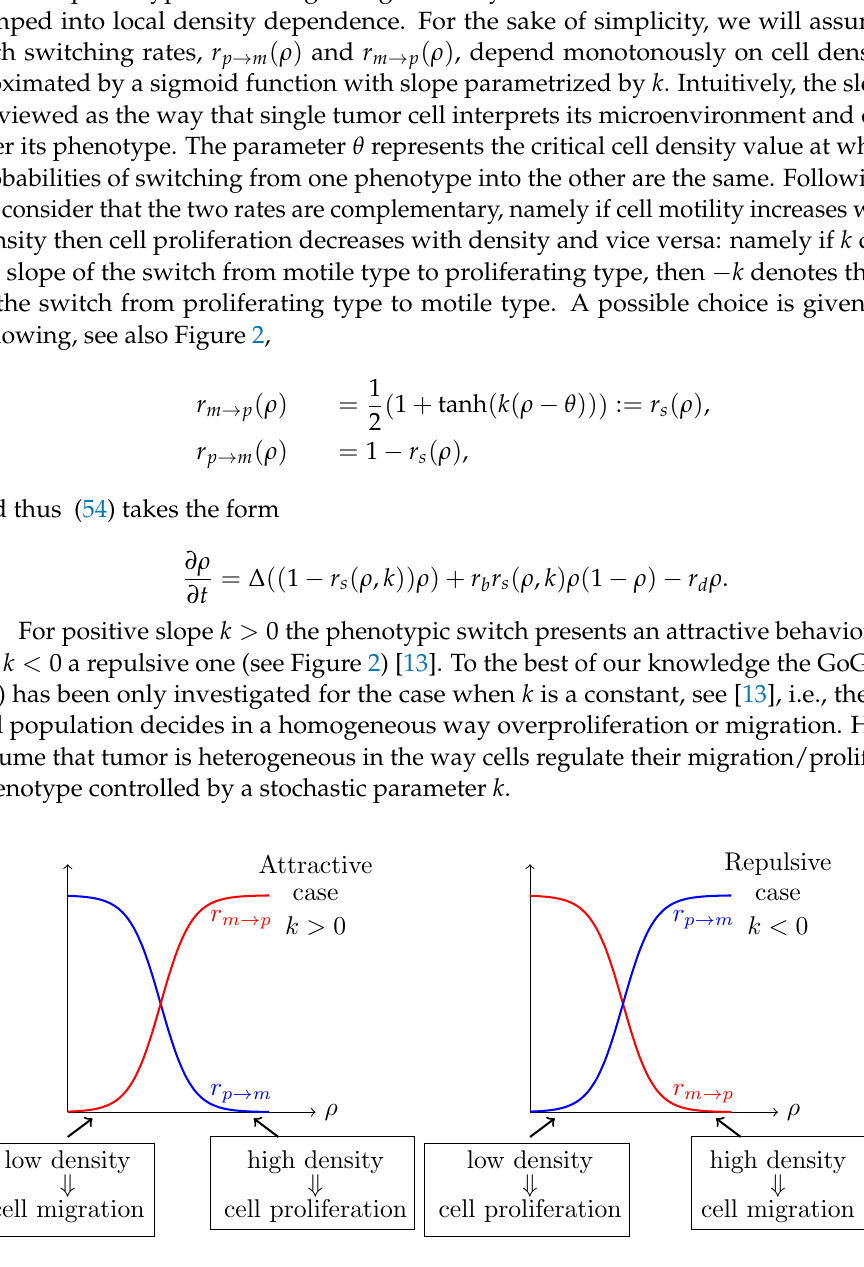
Fig. 2: Sketch of cellular mechanism for di↵erent kind of phenotypic plasticity. In the Figure 2. Sketch of cellular mechanism for different kind of phenotypic plasticity. In the left aggregative left aggregative configuration is represented, while in the right figure, the repulsive configuration is represented, while in the right figure, the repulsive configuration is configuration is represented.